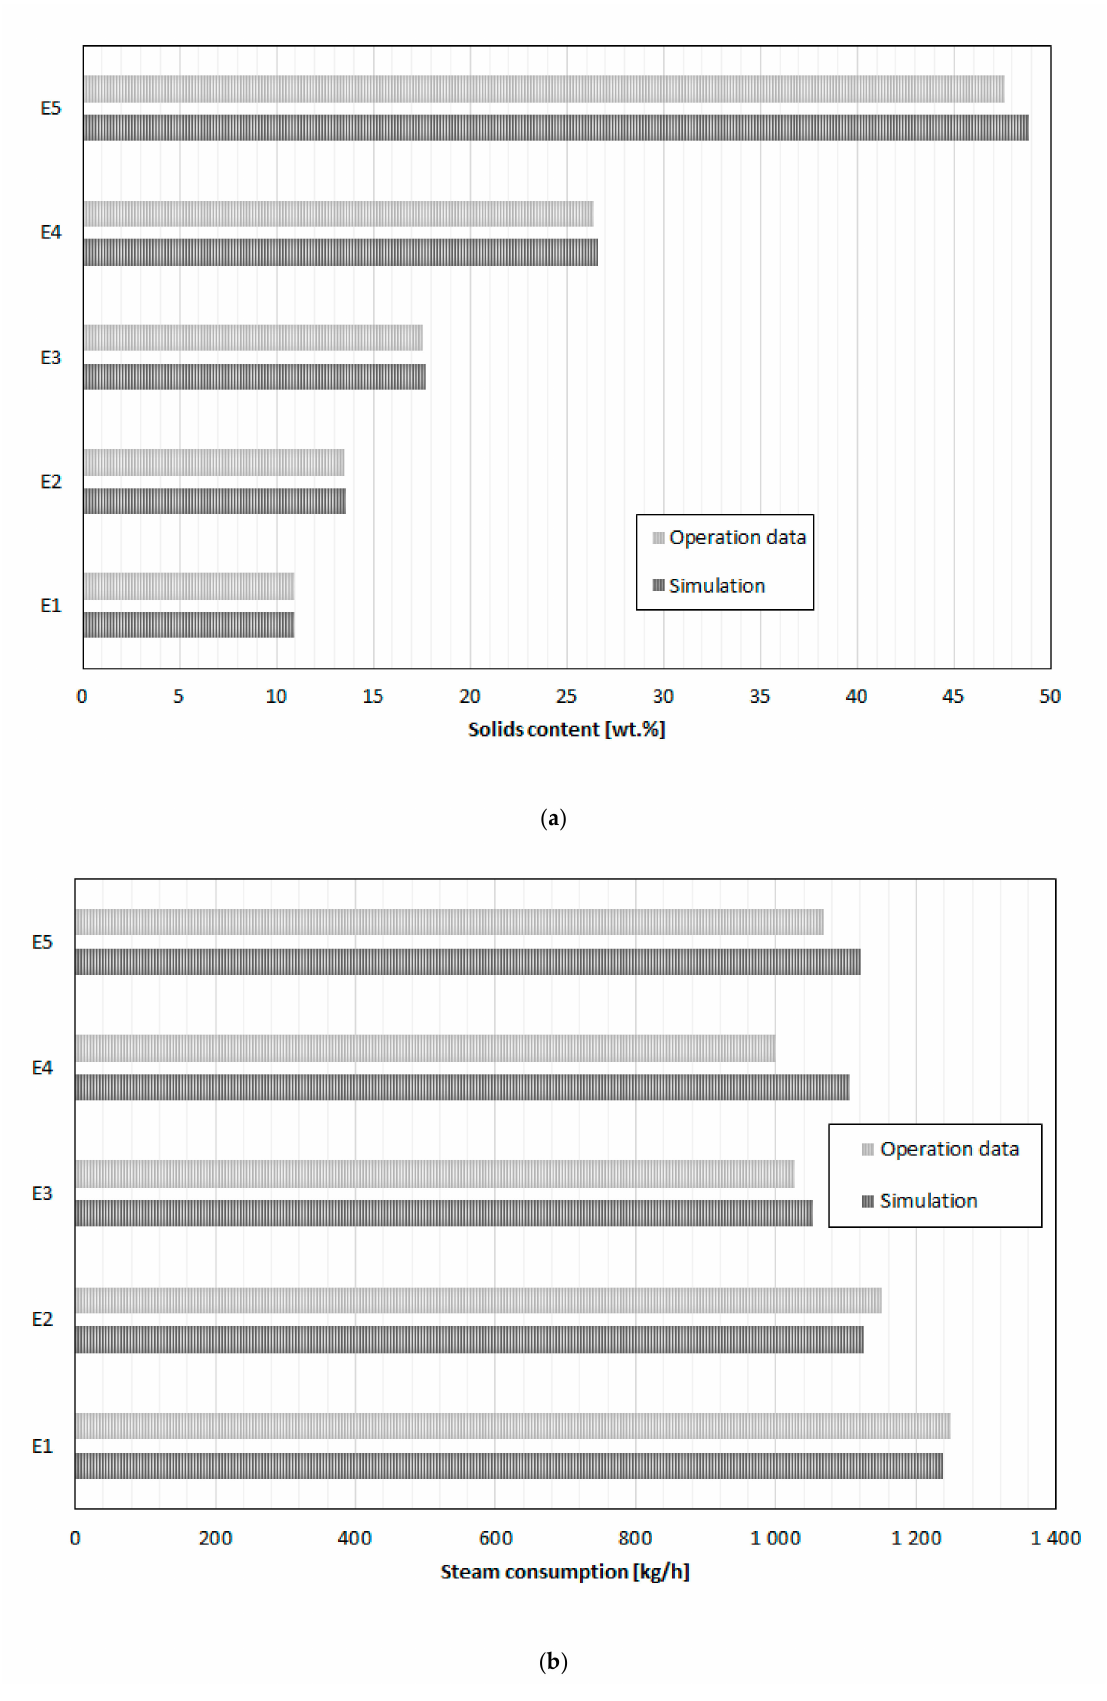
Figure 5. Aspen Plus model verification by solids content ( a ) and steam consumption ( b